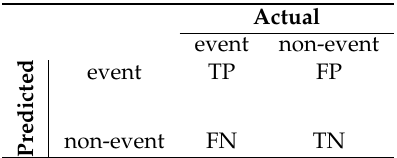
Table 9. Notional confusion